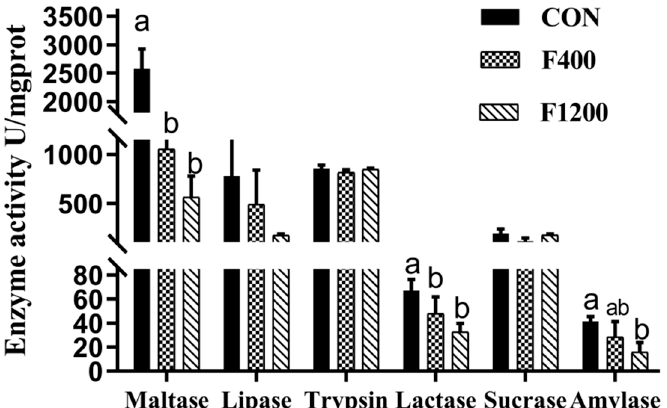
Figure 2. Effects of dietary fluoride levels on digestive enzyme activities of laying hens ( n = 6). Values were showed as the means and SD ( n = 6). a,b Means without common letters above the histogram differ significantly ( p < 0.05). CON, the control group, basal diet; F400 and F1200, diets supplemented with 400, and 1200 mg F/kg feed from sodium fluoride, respectively.